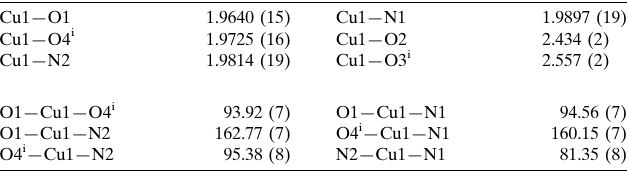
Selected geometric parameters (A˚ , (cid:2) ).